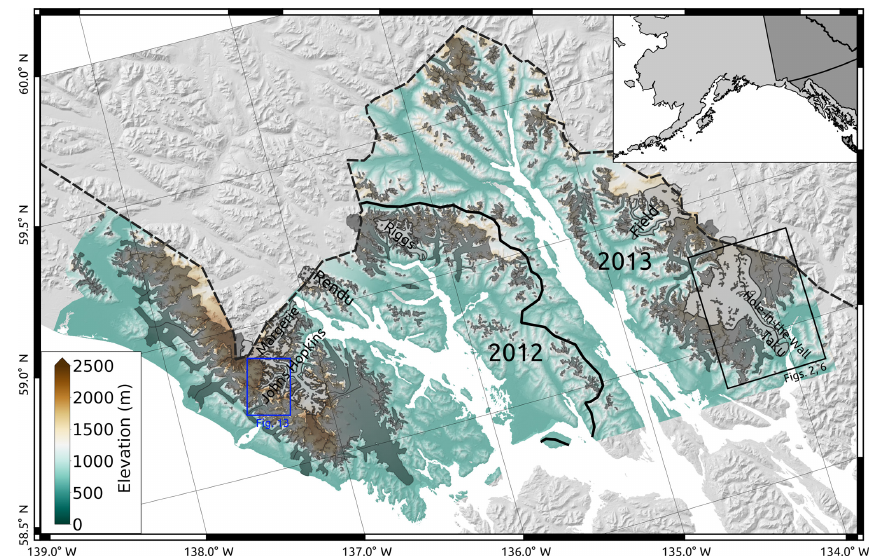
Figure 1. Study area in southeast Alaska, USA. IfSAR DEMs are displayed on top of SRTM hillshade. The solid black line indicates the boundary between 2012 and 2013 IfSAR acquisitions. The dashed black line indicates the US–Canada border. Dark gray outlines show glacier extents; named glaciers (light gray outlines) are discussed further in the following sections. The black outline indicates the extents of Figs. 2 and 6; the blue outline indicates the extent of Fig.